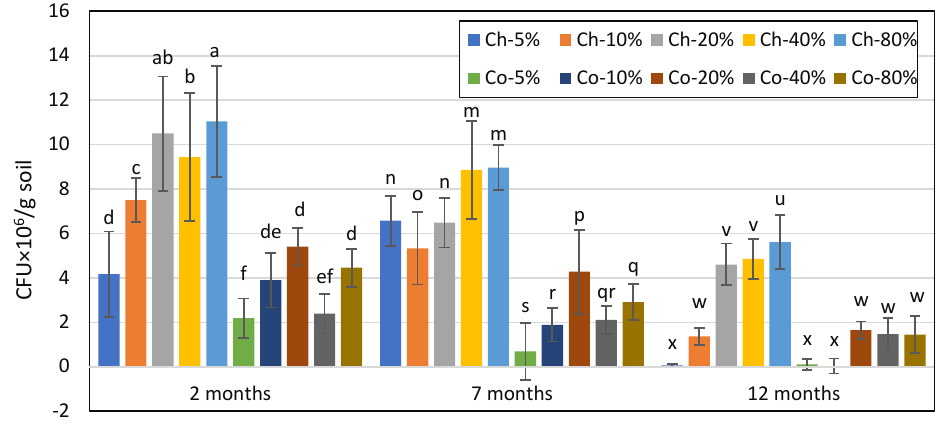
Figure 5. Trichoderma longibrachiatum Tr58 contents in conidia- and chlamydospore-amended soils with different moisture contents in a natural environment. Lowercase letters a–f, m–r, and u–x respectively indicate the significant difference of Tr58 contents in different moisture soils amended chlamydospores and conidia-mended soils at 2, 7, and 12 months later, and the same letter above the column indicates no significant difference at p < 0.05. Ch: chlamydospore; Co: conidia; 5%, 10%, 20%, 40%, 80%: soil moistures.